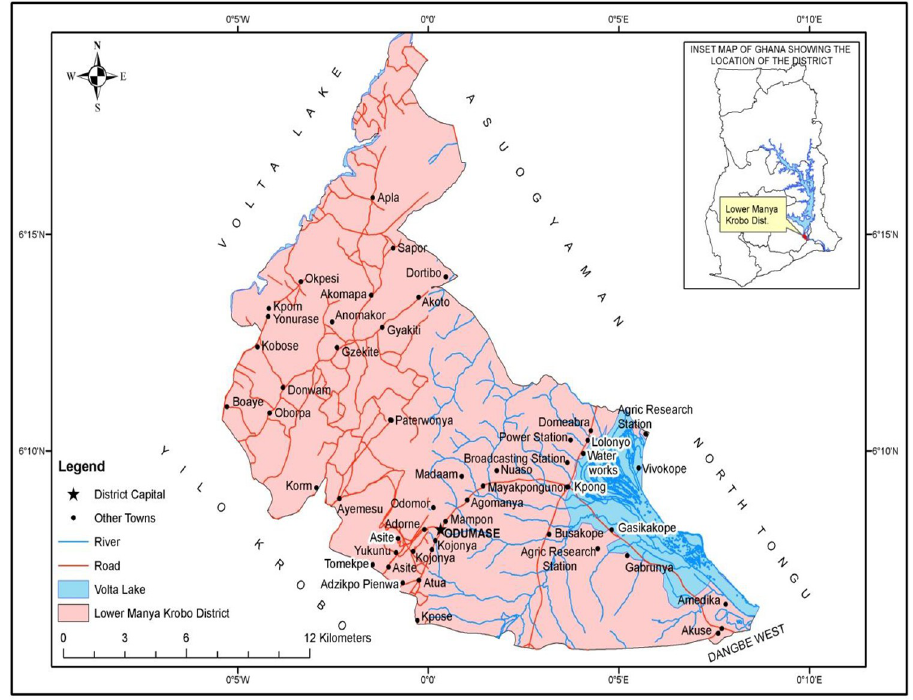
Fig 1. Map of the lower Manya Krobo municipal area showing the selected communities. (Source: adapted from the previous study conducted by Mensah and colleagues [43]).